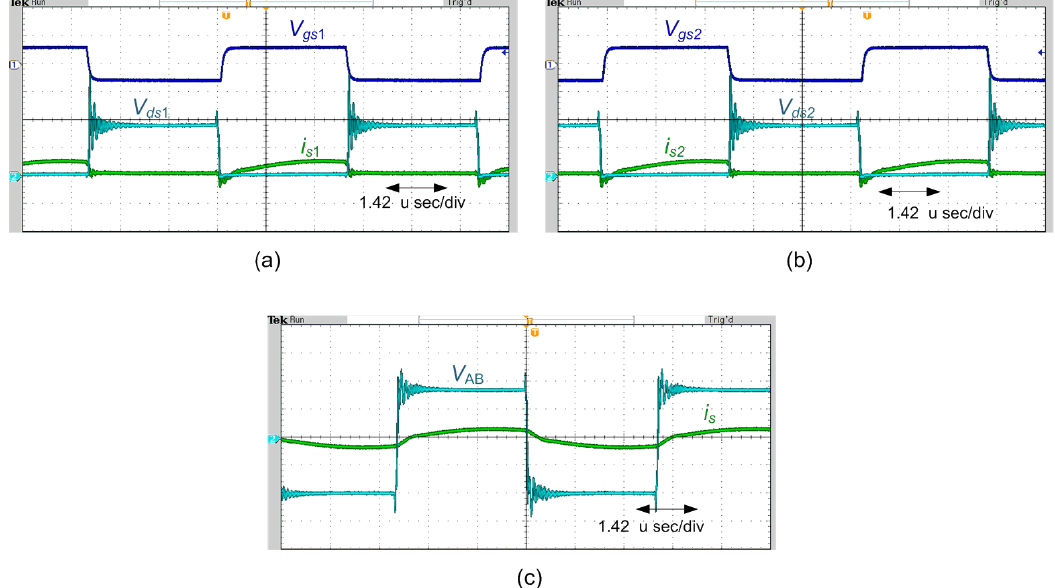
Figure 9. Experimental waveforms at V 1 = 42 V, V 2 = 48 V for 25 Watt load ( a ) V gs 1 : (25 V/div), V ds 1 : (50 V/div), i S 1 : (2 Amp/ div); ( b ) V gs 2 : (25 V/div), V ds 2 : (50 V/div), i S 2 : (2 Amp/ div); ( c ) V AB : voltage across inverter (25 V/div), i s : resonant current (4